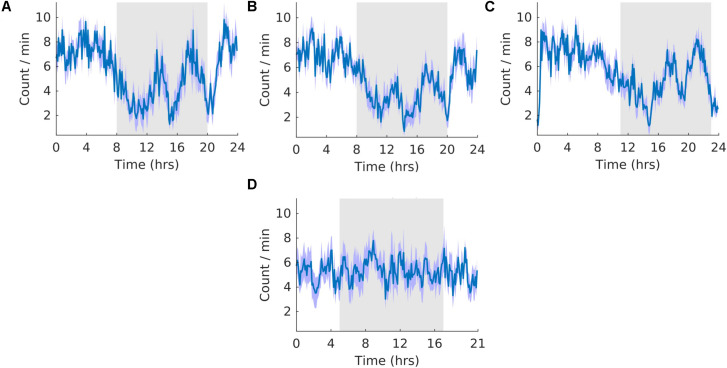
Sleep spindles. (A) Group average normalized waveforms for the 6 days pre-T21 stage of the experiment. (B) Group average normalized waveforms for the 6 days T21 stage of the experiment. (C) Group average normalized waveforms for the 6 days post-T21 stage of the experiment. (D) Group average normalized waveforms for the 6 days T21 stage of the experiment framed for a period of 21 h. The gray shaded area represents lights off, and the purple shaded area represents standard error of the mean.